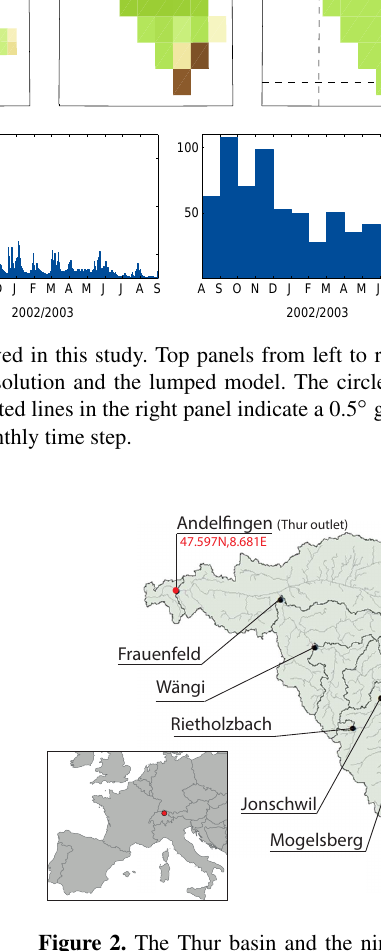
Figure 2. The Thur basin and the nine sub-basins for which dis- charge data were